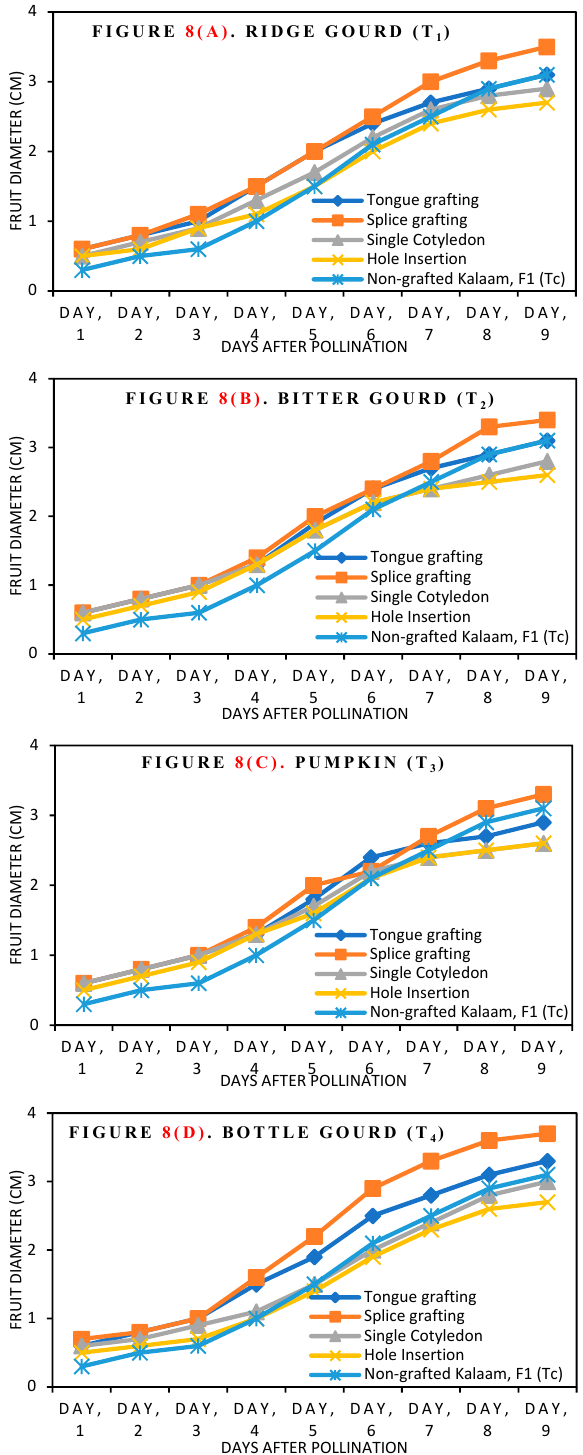
Figure 8. ( A – D ). E ff ect of grafting on Cucumber fruit development (fruit diameter) after Figure 8 (A, B, C, D). Effect of grafting on Cucumber fruit development (fruit diameter) after pollination.